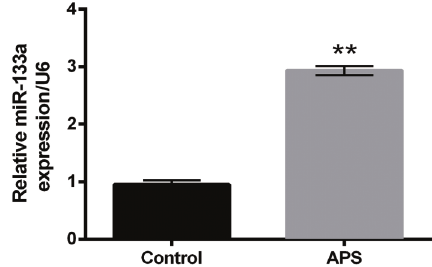
Figure 3. Astragalus polysaccharides (APS) induced up-regulation of miR-133a in MG63 cells. MG63 cells were stimulated with 10 mg/mL APS. Non-treated cells acted as control. Expression of miR-133a was determined by quantitative reverse transcrip- tion PCR. Data are reported as means ± SE of three indepen- dent experiments. **P o 0.01 ( t